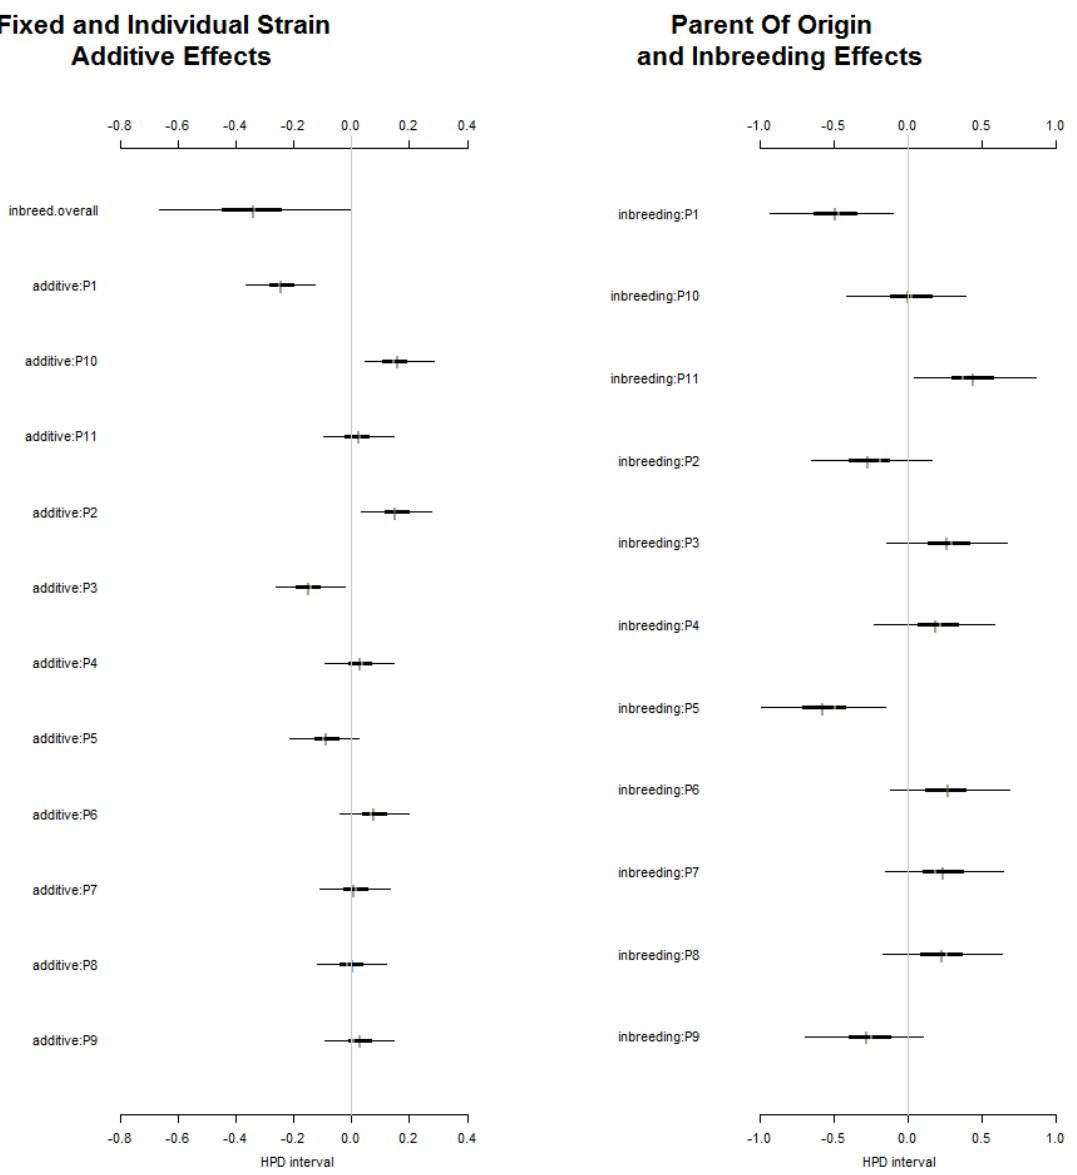
Figure 4. Highest posterior density (HDP) intervals of parent-specific additive effects, parent of origin and inbreeding effect of the 11 parents studied.